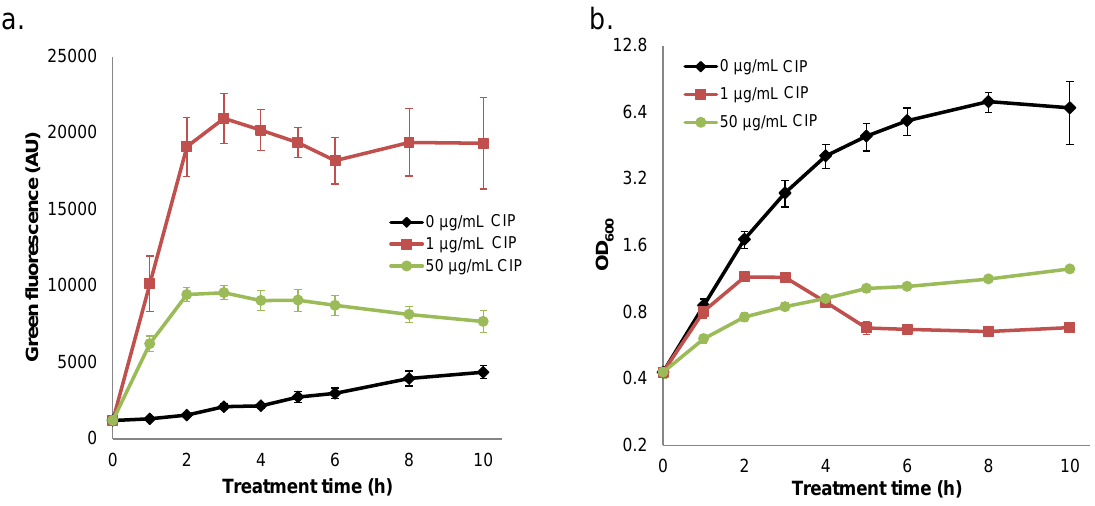
Figure 4. Ciprofloxacin (CIP) treatment of S. aureus NCTC 8325 containing a